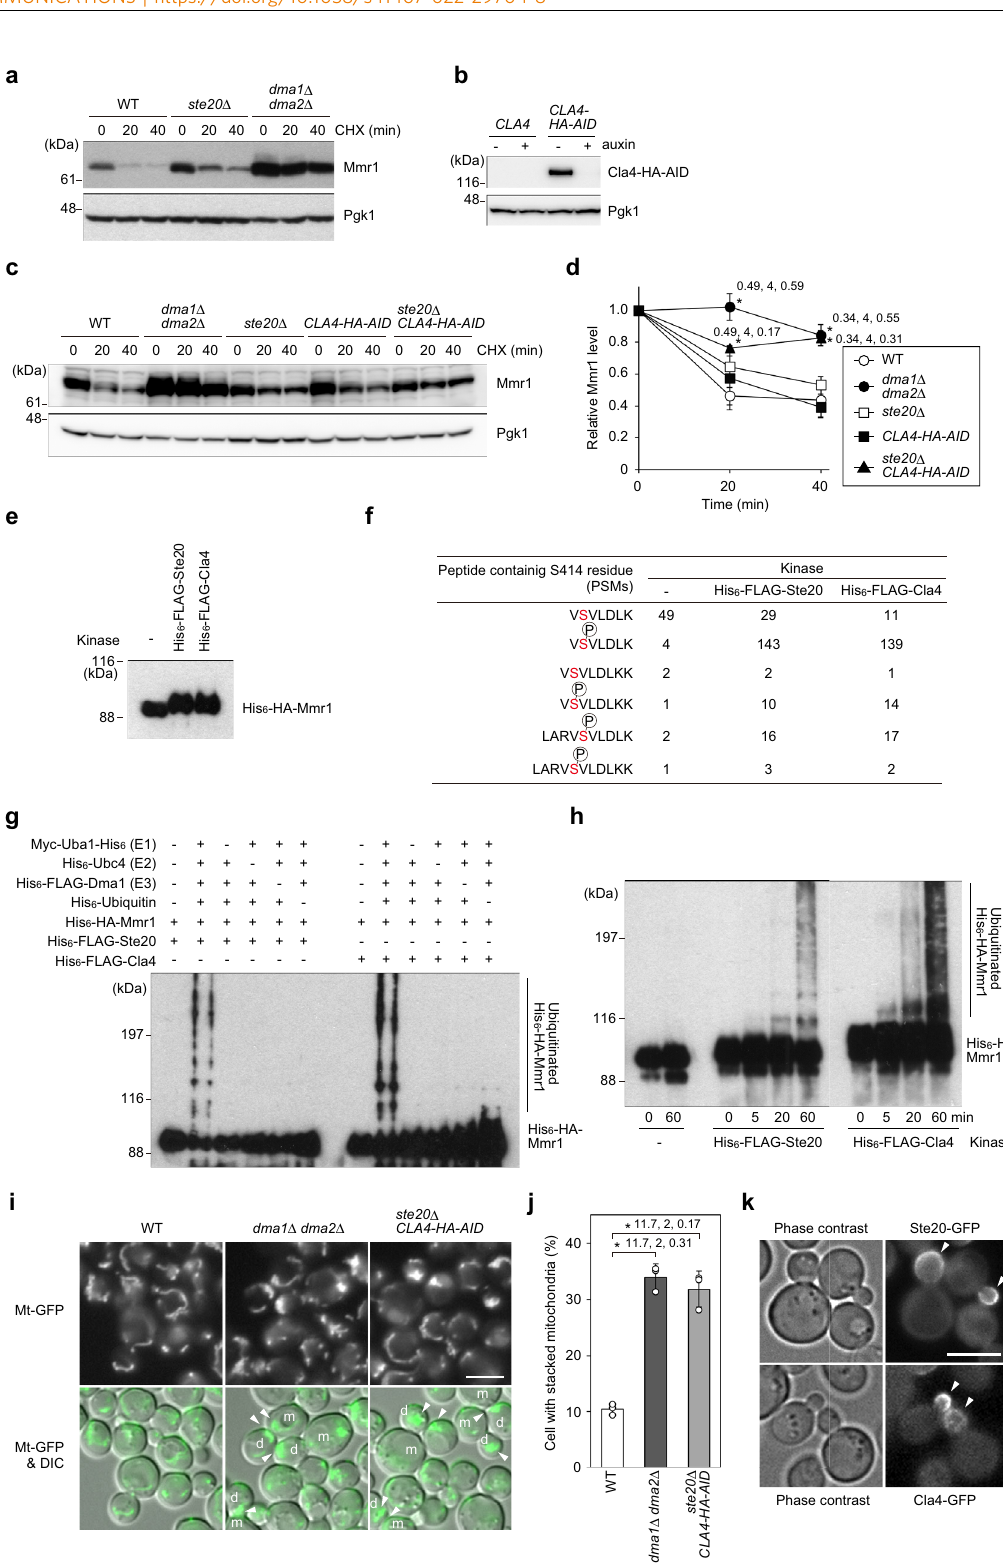
auxin-treated ste20 Δ CLA4-HA-AID cells. Mitochondria stacked at the bud tip and bud neck in auxin-treated ste20 Δ CLA4-HA- AID cells, similar to that in dma1 Δ dma2 Δ cells, implying that Ste20 and Cla4 are required for normal mitochondria distribution (Fig. 5i, j). To ensure proper mitochondrial inheritance to daughter cells, Mmr1 should be degraded only after the mitochondria have